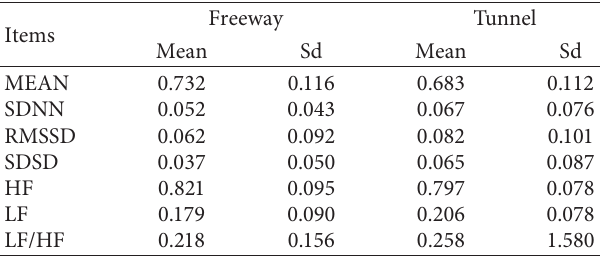
Table 4: Time- and frequency-domain indicators of the driver’s heart rate variability. Items